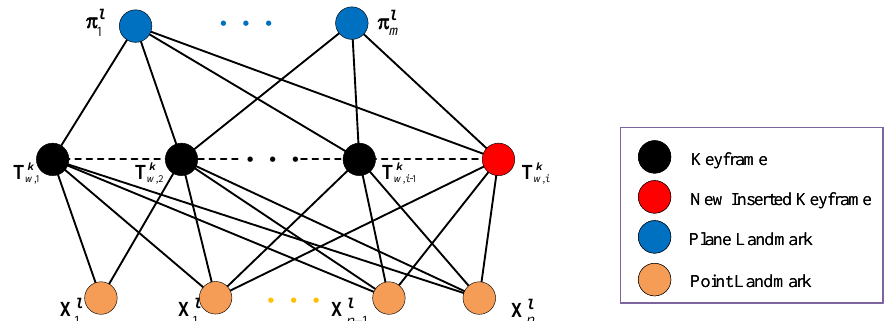
Figure 2. Point–plane-based factor graph that is used to represent the local map. Four colors denote four different elements. When a new keyframe (red circle) is inserted, the pose of the keyframes (black circles), point landmarks (blue circles), and plane landmarks (yellow circles) are optimized by minimizing the error cost function constructed by the factor graph.